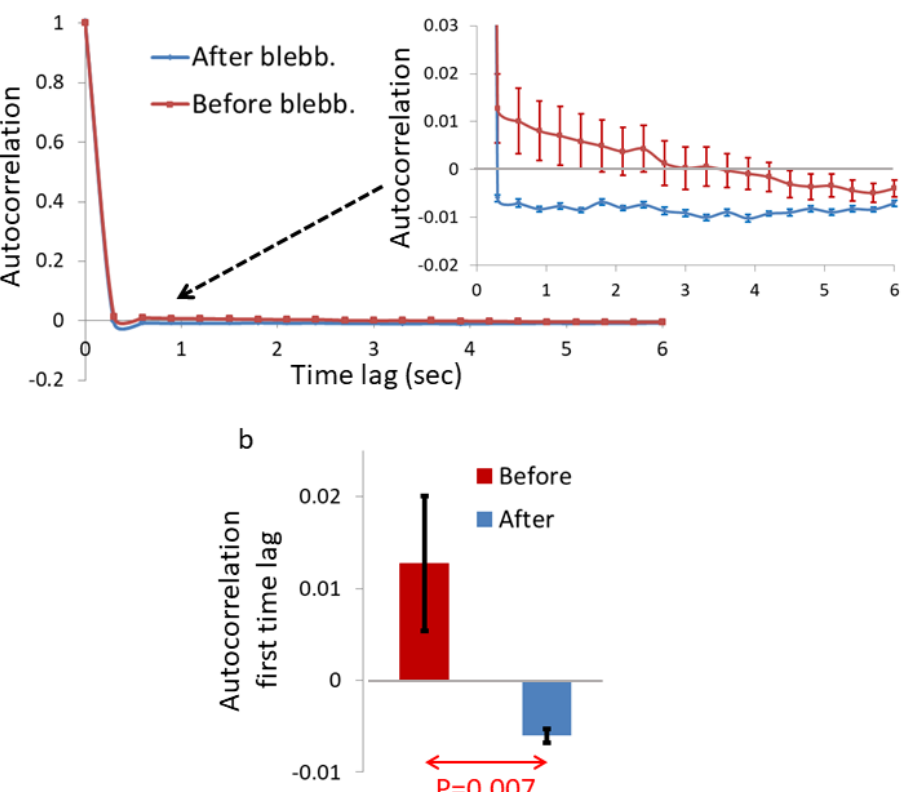
Figure 4. Autocorrelation of pixel intensities in the ROIs of Ca ++ -Fluo-4-highlighted live cells before and after blebbistatin treatment. ( a ) Average autocorrelation values of the pixel intensities in the ROIs in the cells (N = 31) before blebbistatin treatment, and of the same cells after 10 µ M blebbistatin treatment. ( b ) Average autocorrelation results of the first time-lag in the cells before blebbistatin treatment in comparison to the corresponding results in the same cells after blebbistatin treatment. Error bars are SEM, and p -value is shown in ( b ).